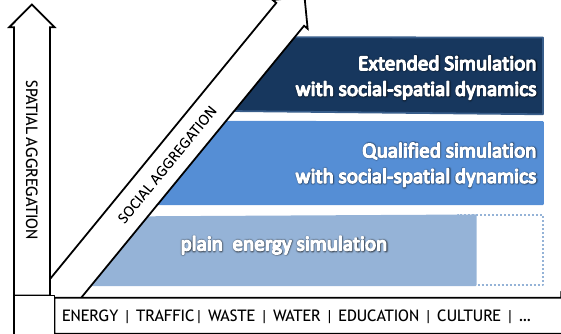
Figure 4. OMG SysML Diagram Taxonomy (Friedenthal et al,